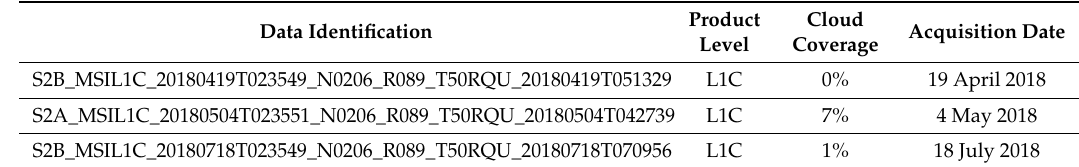
Table 3. Sentinel-2 data used in this study.